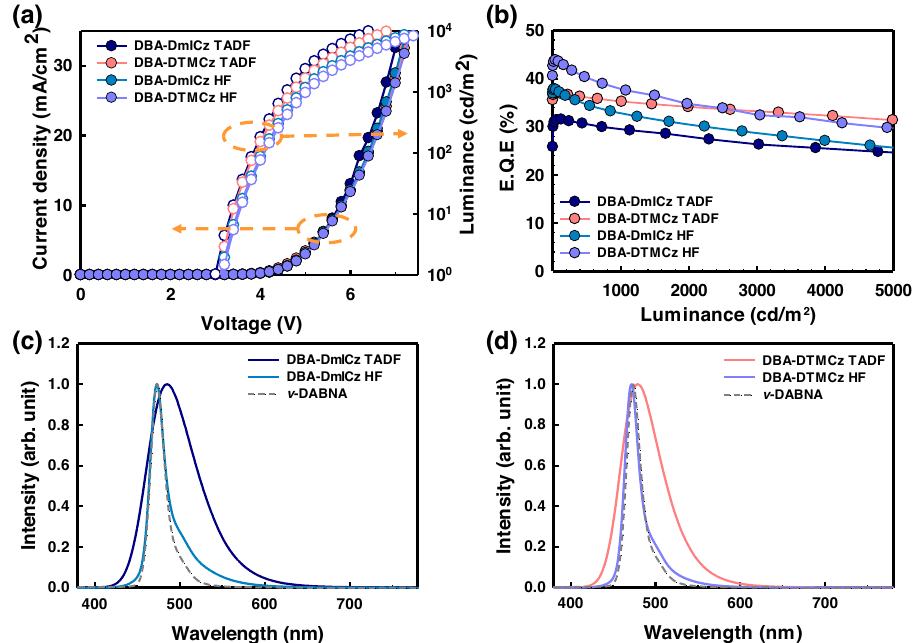
Fig. 5 | The device performances. a J-V-L curves, and b EQE versus luminance. The EL spectra of TADF and HF devices of c DBA-DmICz and d DBA-DTMCz with 1% of